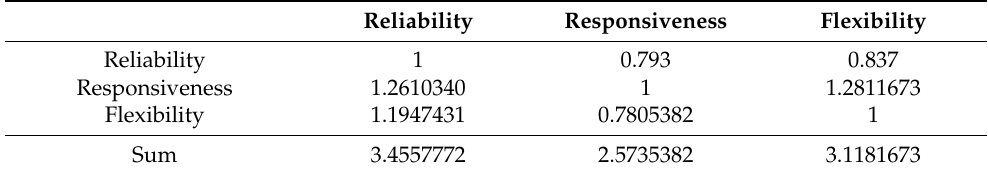
Table A2. Pairwise comparison matrix.